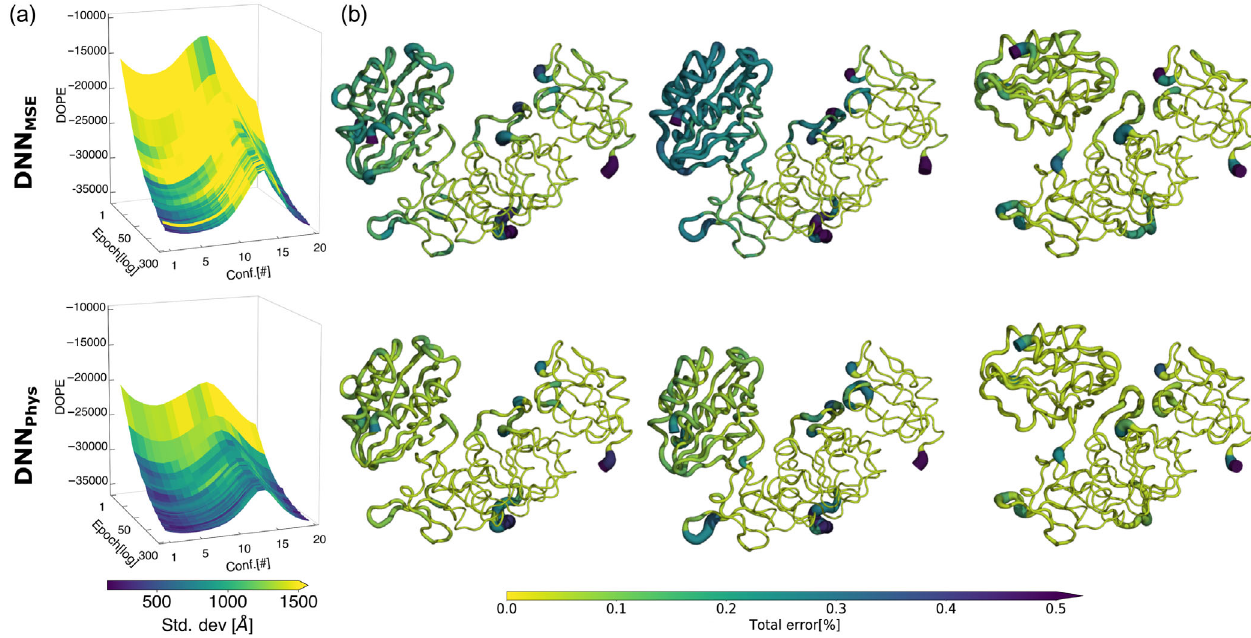
FIG. 2. Performance of the neural network trained with to minimize MSE alone or in conjunction with physical terms (labeled on the left). At every epoch, each network was asked to generate 20 conformations interpolating from MurD closed to open state. (a) At each epoch, we calculate the DOPE score of each conformation and report the mean values from the 10 repeats on the vertical axes with color corresponding to the standard deviation. Physics-based loss functions lead to interpolations with better structural quality reflected by lower DOPE scores. (b) The network-predicted protein conformations of open (left), intermediate (center), and closed (right) states at the last epoch, shown in sausage representation with the thickness and color corresponding to the percentage error at the residue